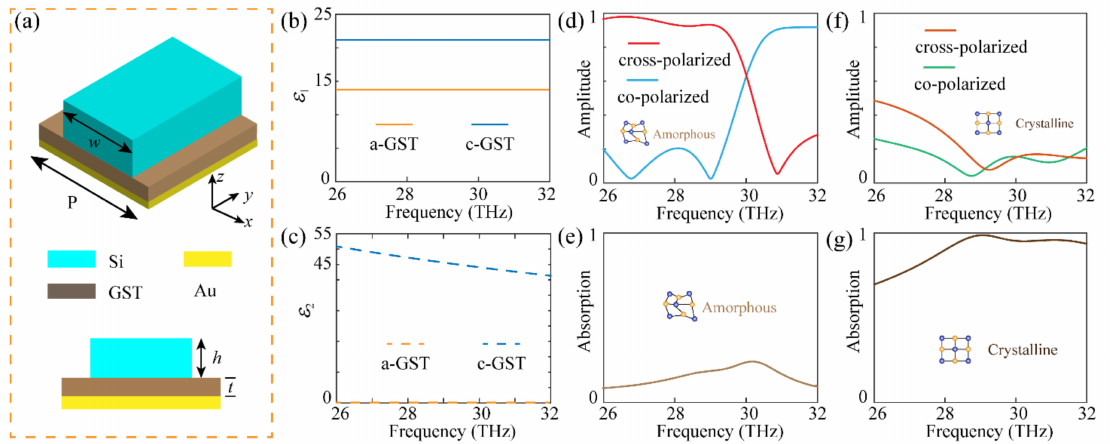
Figure 2. The schematic diagram of the unit cell and simulated performance of the device. ( a ) The three dimensional (top) and section view (bottom) of the unit cell. The corresponding geometrical parameters are P = 5.8 µ m, w = 3.77 µ m (filling ratio 0.65), h = 2 µ m, and t = 0.3 µ m. ( b , c ) Measured real part of permittivities ε 1 ( b ), and imaginal part ε 2 ( c ) of the amorphous and crystalline GST (a-GST and c-GST). ( d , e ) Reflected amplitude of the cross- and co-polarized components under circularly polarized incidence ( d ), and the corresponding absorption ( e ) when the GST is in A-state. ( f , g ) Reflected amplitude of the cross- and co-polarized components under circularly polarized incidence ( f ), and the corresponding absorption ( g ) when the GST is in C-state.